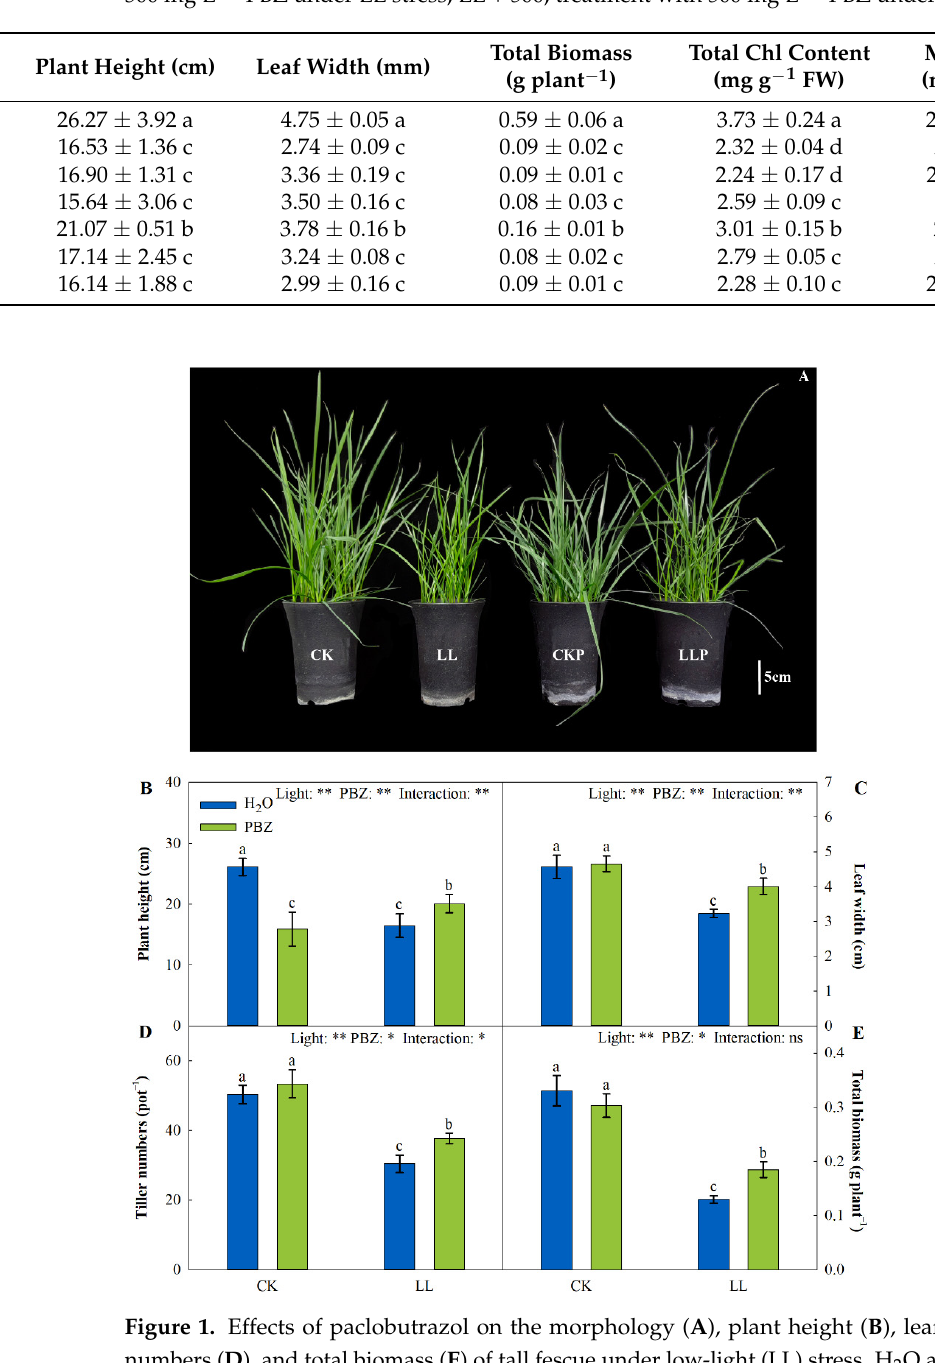
Table 1. Effects of different paclobutrazol (PBZ) concentrations (0, 50, 100, 200, 300, 500 mg L − 1 ) on physiological parameters of tall fescue. Data presented are mean ± SD (n = 3). Different letters next to the number indicate a significant difference at p < 0.05 (Duncan’s multiple range test). CK, control treatment with distilled water; LL, treatment with distilled water under low-light stress; LL + 50, treatment with 50 mg L − 1 PBZ under LL stress; LL + 100, treatment with 100 mg L − 1 PBZ under LL stress; LL + 200, treatment with 200 mg L − 1 PBZ under LL stress; LL + 300, treatment with